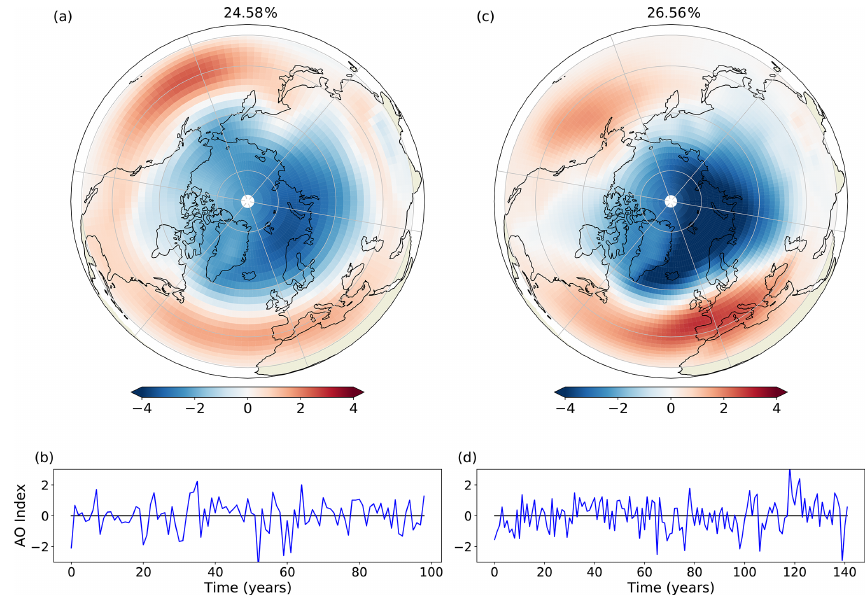
Figure 14. The AO as represented by the first EOF and PC computed using deseasoned and latitude-weighted sea level pressure for FORTE 2.0 (a, b) and 20CR (c, d) .